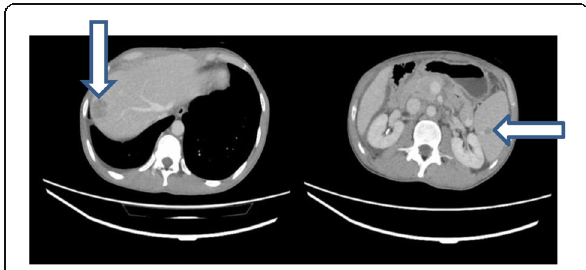
Fig. 1 Spiral CT scan showed well-defined solid lesions in the liver (vertical arrow) and spleen (horizontal